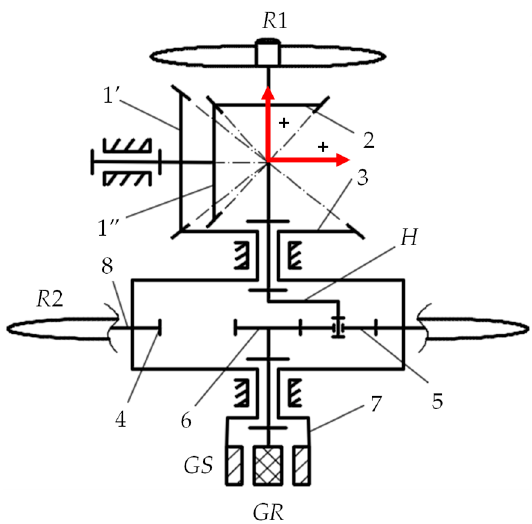
Figure 2. The conceptual scheme of a wind system containing: two counter-rotating wind rotors, a 1 degree of freedom (DOF) speed increaser and a counter-rotating electric generator.